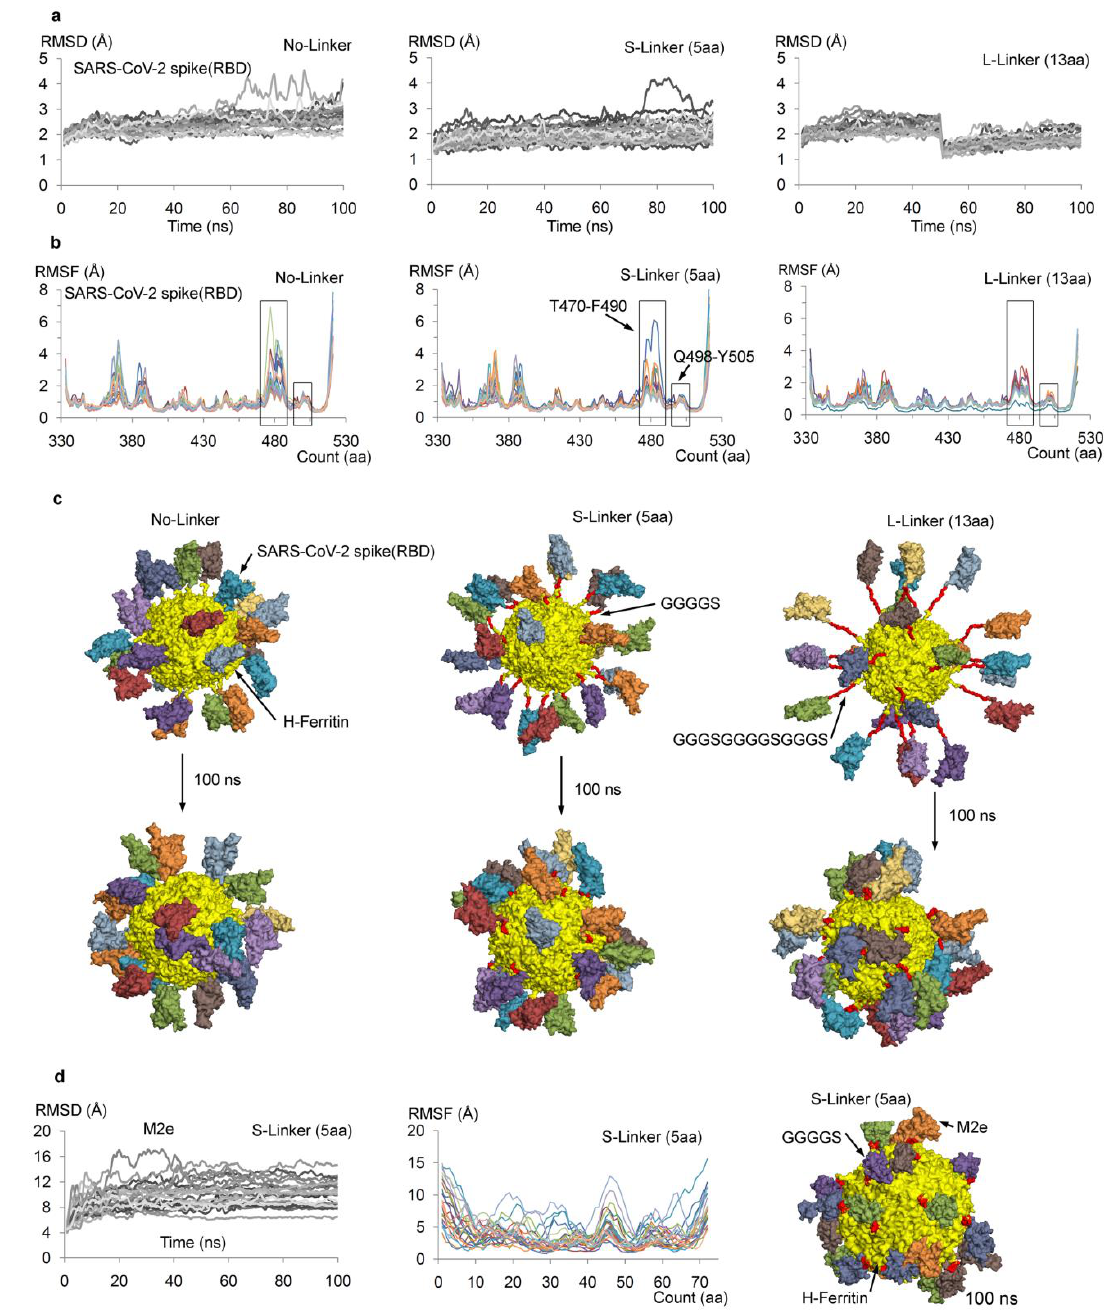
Figure 2. Dynamics of the SARS-CoV-2 spike RBDs when presented over the ferritin nanocage, with characterization and validation of chimeric constructs by molecular dynamics simulations. ( a ) For the individual (total 24) spike RBD monomers over the H-ferritin cage, the root mean square deviation (RMSD) was computed, showing a time-dependent change in non-hydrogen atoms. ( b ) The root mean square fluctuations (RMSF) for each residue based on the C α atoms from the spike RBDs. Residues 470TEIYQAGSTPCNGVEGFNCYF490 and 498QPTNGVGY505, suggested to bind with the ACE2 receptor, are highlighted [34 – 36]. ( c )The conformations detected for the SARS-CoV-2 spike RBD-H_ferritin complexes, with different chimeric constructs varying in the length of the linker (No-Linker, 5 aa S-Linker, and 13 aa L-Linker). The protein coordinates were retrieved from the beginning and end of the molecular dynamics simulation. ( d ) The M2e-H_ferritin system (5 aa S-Linker), the conformation dynamics, and the structural properties (RMSD and RMSF of M2e) were further compared with the modeled spike RBD-H_ferritin constructs. The H-ferritin cage is shown as the yellow surface, the linkers are in red, and each monomer of the SARS-CoV-2 spike RBD is represented as the surface in different color.